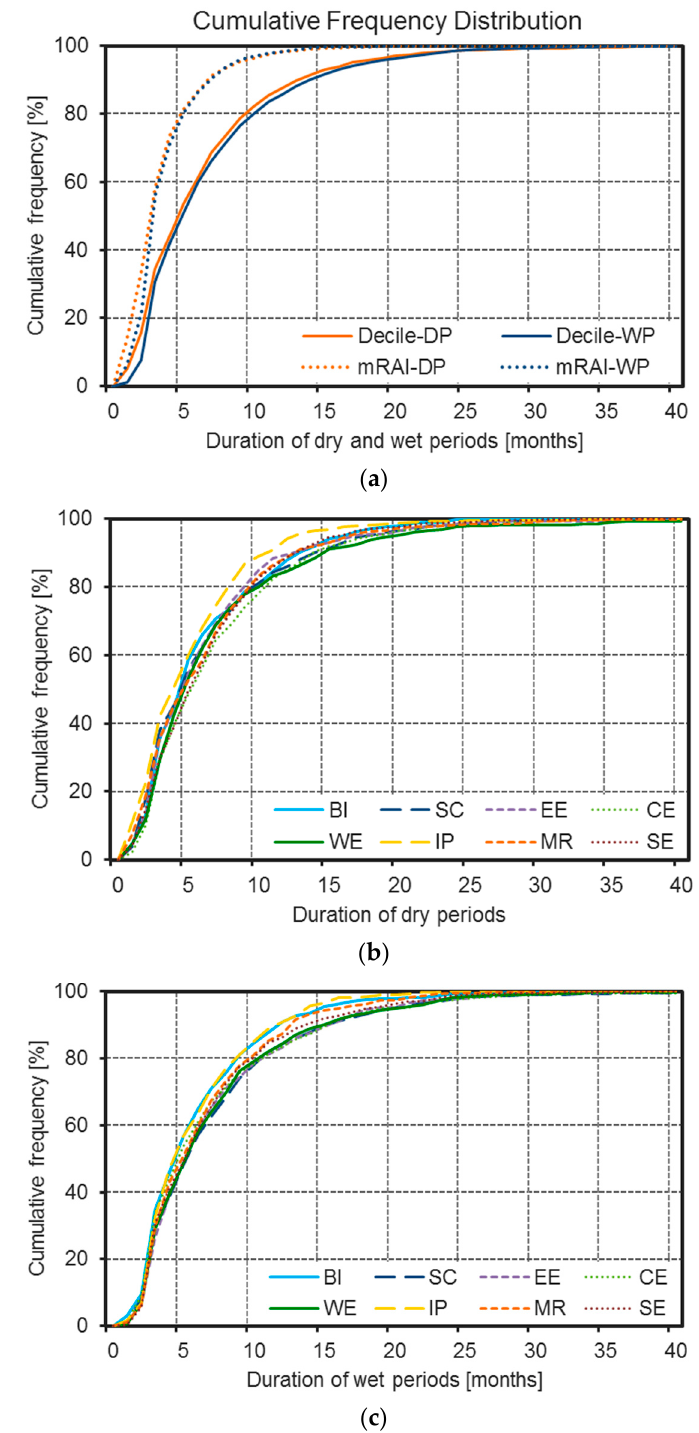
Figure 3. Cumulative frequency distribution of the duration of dry (DP) and wet periods (WP) for period 1966–2015. Part ( a ) show the results for Europe (average of 220 stations) according to the decile and mRAI definition. The parts ( b ) and ( c ) show the results of the sub-regional analysis for decile-DP ( b ) and decile-WP ( c ). Therefore, the region abbreviations and colors used for lines of individual sub-regions refer to those introduced in Figure 1.